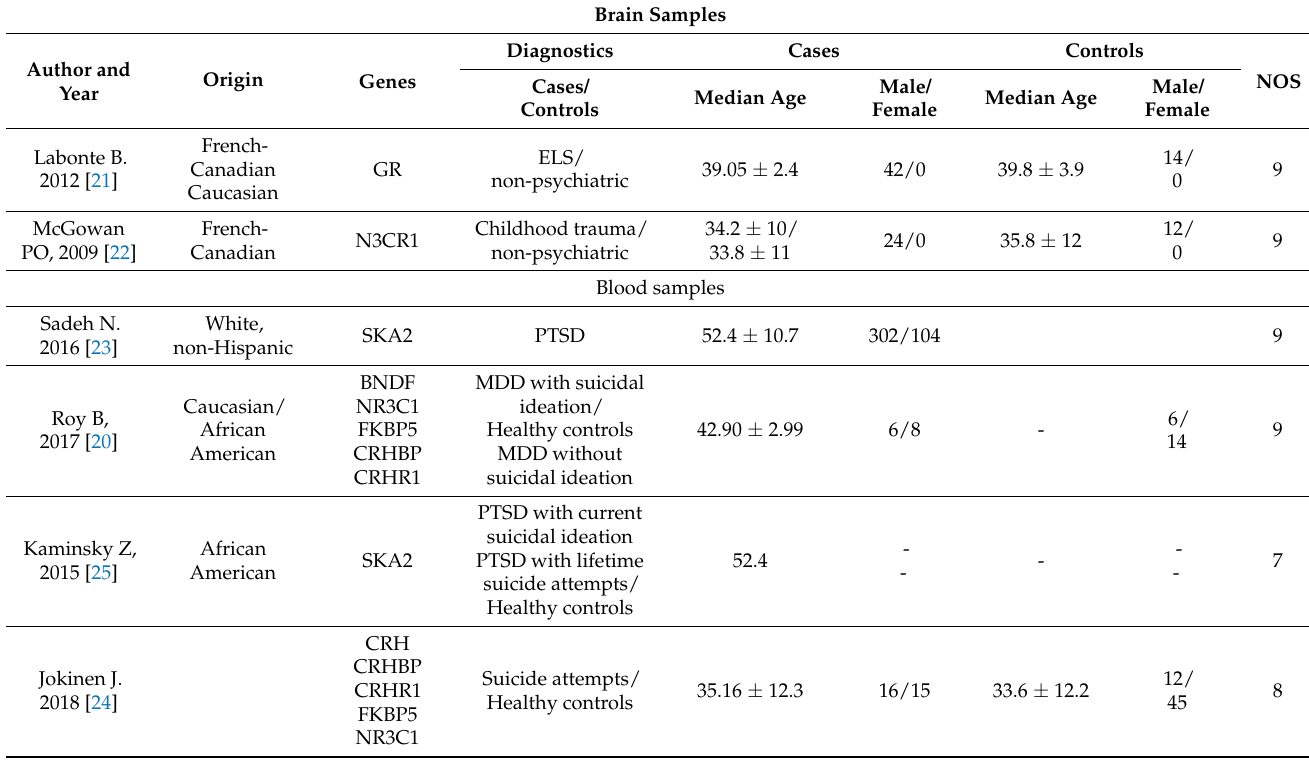
Table 1. Characteristics of the included publications that evaluated methylation of HPA genes expression (mRNA) in the pathogenesis of suicide behavior.